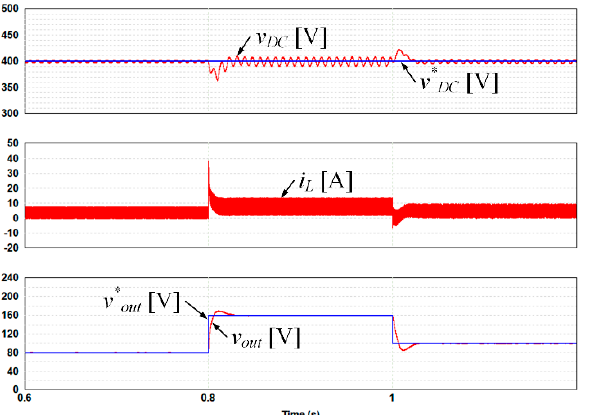
Figure 10. Simulation results of output voltage control of integrated OBC using ( a ) PI control and ( b ) the proposed MPC method.